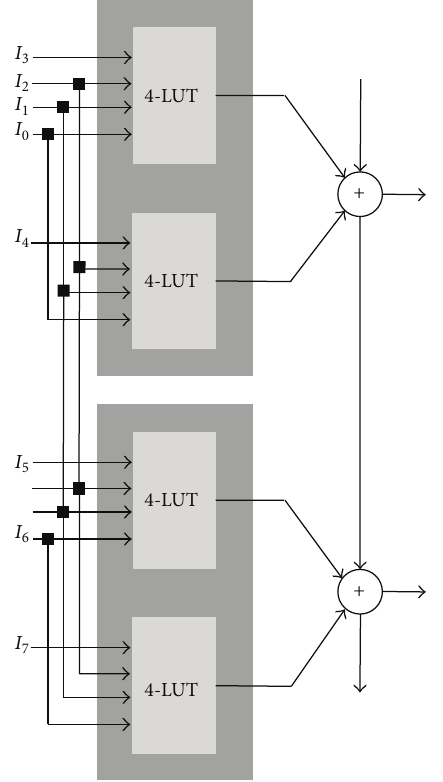
Figure 1: Stratix IV, V ALM when used in arithmetic mode.